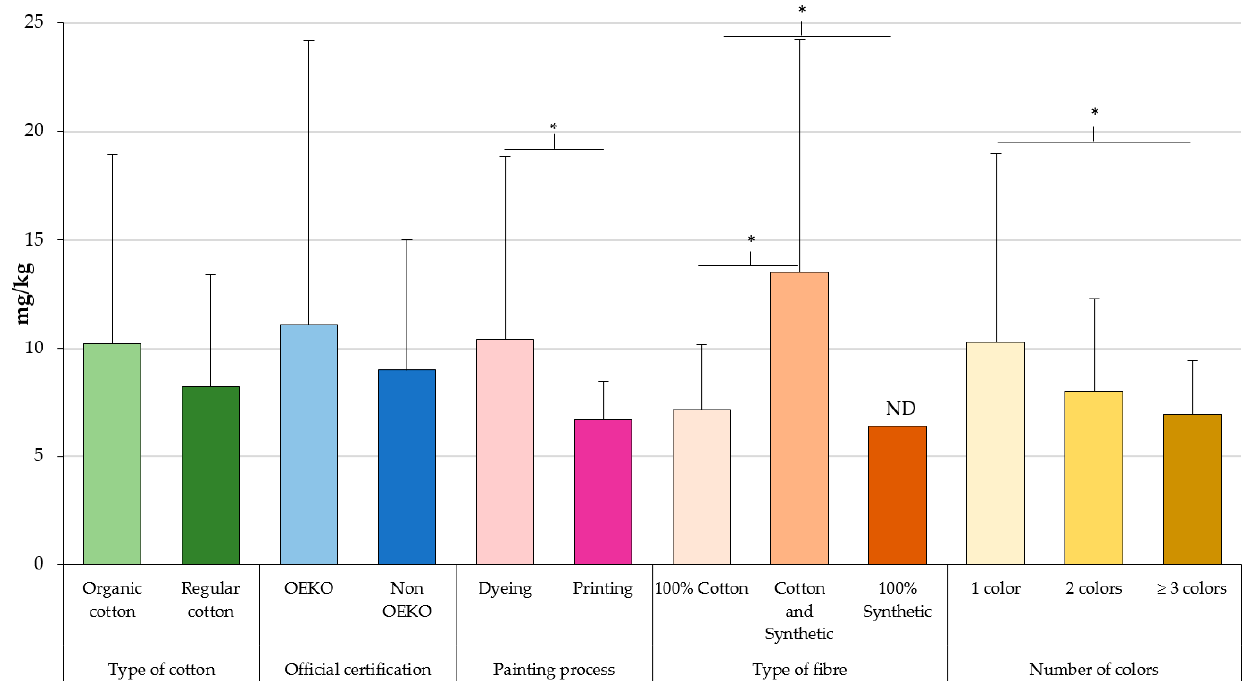
Figure 1. Formaldehyde concentrations according to a number of factors, including cotton production, OEKO-TEX ® Standard 100, painting process, type of fibre, and number of colours. * An asterisk indicates significant differences at p < 0.05. ND: Not detected.